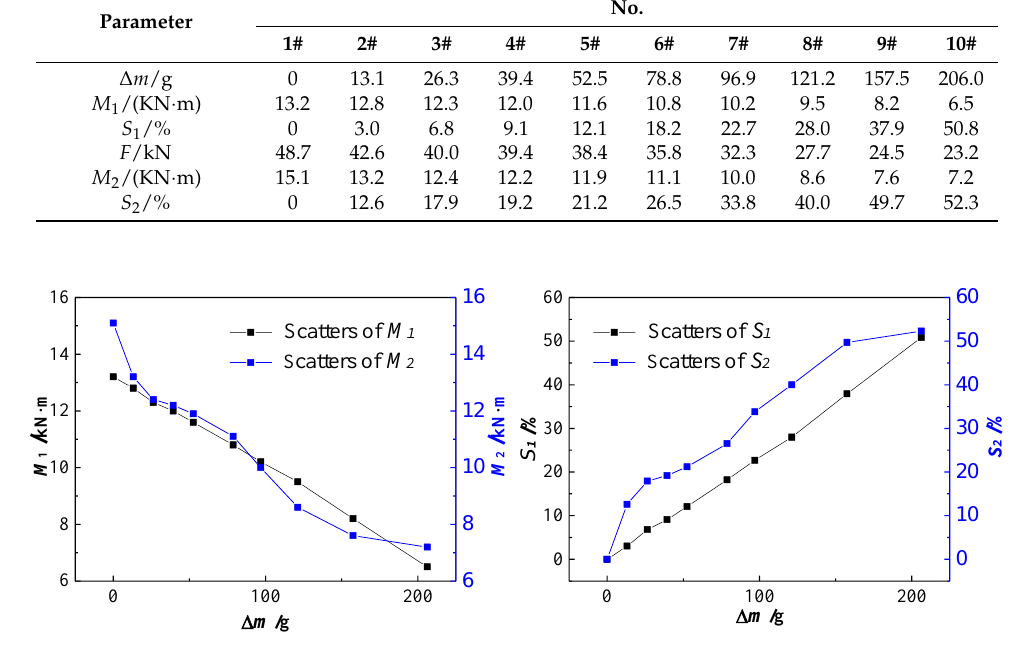
Figure 11. Diagram of the relationship between M and Δm .